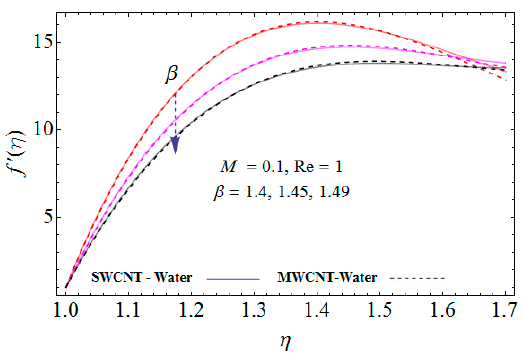
Figure 6. The impact of the thin film thickness parameter versus velocity field.